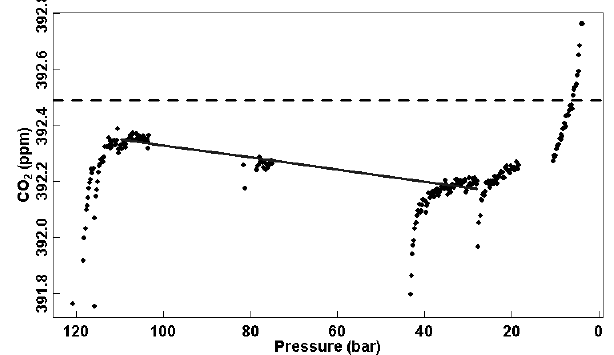
Fig. 2. (a) One exponential curve fit for the response time from calibration to sample gas, and the 90% response time ∼ 4s, (b) sum of two exponential curve fit for the response time from one sample to another sample gas, and the 90% response time is ∼ 9s. The dashed lines indicate the 90% responses.